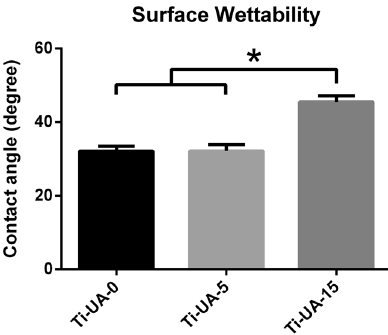
Fig. 3 Contact angles of different titanium surfaces pre-treated with 0 mg/dL 、 5 mg/dL and 15 mg/dL uric acid. Results are presented as mean ± SD (* p <